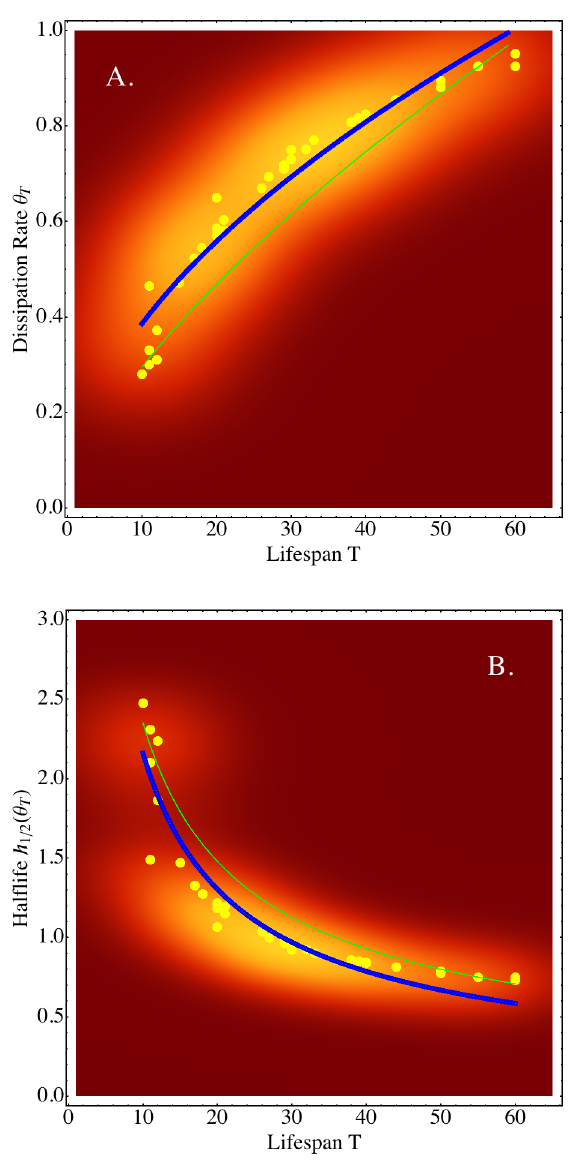
Figure 6. Failures are Dissipated More Slowly in Shorter-lived HSCs than in Longer-lived HSCs. A: We determined the dissipation rates h T (yellow dots; vertical axis) relative to the lifespan T (horizontal h T ( t ) dt for (0,2) -truncated failure rates. The axis) using h T : ~ Ð T { 2 t 0 lower bound t 0 of the integrand was derived in Theorem 2. To highlight the general tendency in the data, not implying any dependencies of consecutive data points, we fitted the data to a non-linear model h T ~ 0 : 113 T 0 : 53 (blue line; goodness-of-fit Akaike Information Criterion: AIC ~{ 93 : 87 ); parameter p-values 6 : 54 | 10 { 11 and 5 | 10 { 18 ). Calculation of h T by regressing to normal noise produced a slightly lower exponent T 0 : 67 (fitted curve indicated by green line). B: Half-lives of dissipation rates (yellow dots; vertical axis) relative to individual lifespans (horizontal axis). To highlight the general tendency in the data, we fitted the data to a non-linear model ( T ) ~ 11 : 57 T { 0 : 729 (blue 1 = 2 line; goodness-of-fit Akaike Information Criterion: AIC ~{ 93 : 86 ; parameter p-values 5 : 69 | 10 { 8 and 1 : 67 | 10 { 15 , respectively). The model of half-lives obtained from experimental data (green line) is shown for comparison. In both graphics A and B, we used contour plots of the respective data sets ( T , h t ) and ( T , ( h T )) , respectively, 1 = 2